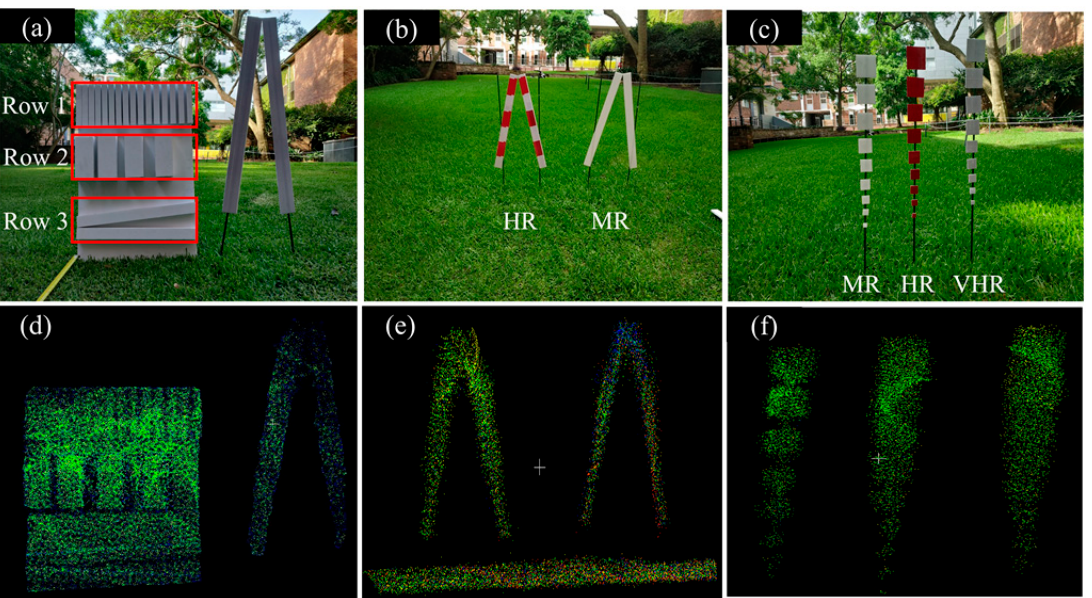
Figure 1. Experimental tests for prototype development: ( a ) A barcode pattern with different length and spacing. Row 1 has spacing ranging from 1 mm to 25 mm, row 2 has spacing 30, 40 and 50 mm, and row 3 is a < shaped pattern. ( b ) A ∧ shaped pattern with highly reflective (HR) and moderately reflective material (MR), and ( c ) a square block with 30 mm spacing made of moderately (MR), highly (HR) and very highly reflective (VHR) material was placed in a well-lit environment. ( d ) Point cloud corresponding to figure ( a ), ( e ) point cloud corresponding to figure ( b ), and ( f ) point cloud corresponding to figure ( c